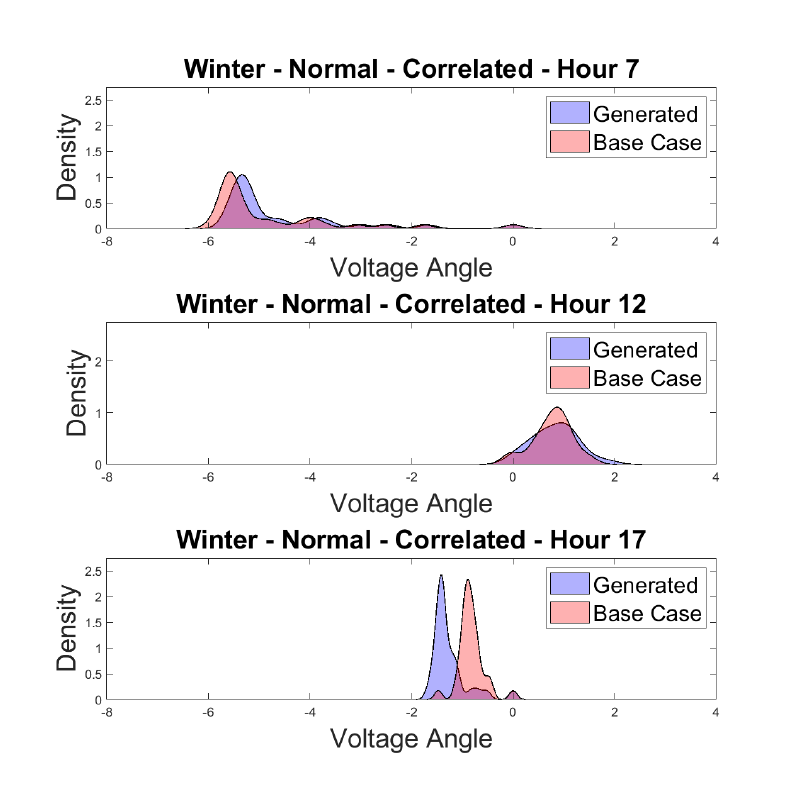
Figure 15. Voltage angle PDFs for winter normal −